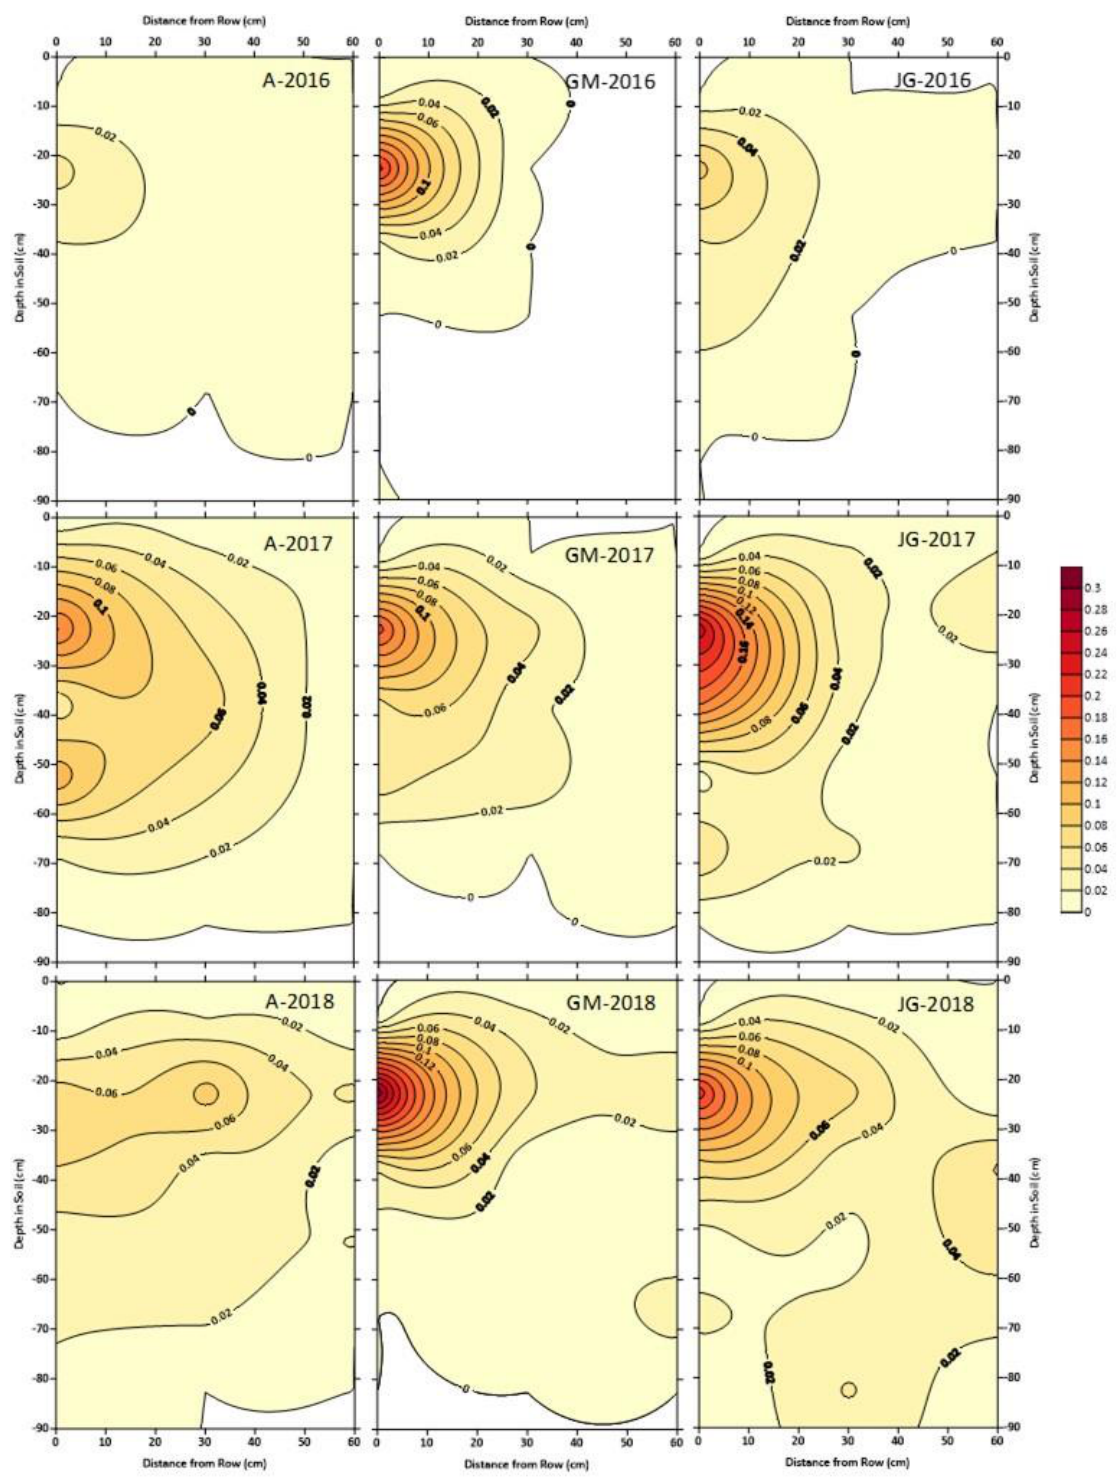
Figure 1. Fleshy root length density (FL-RLD) of three asparagus ( Asparagus officinalis L.) cultivars (Atlas (A), Guelph Millennium (GM), Jersey Giant (JG)) for sampling years 2016, 2017, and 2018. The three cultivars (A, GM, JG) are aligned in the columns while the years (2016–2018) are aligned in the rows. Isolines represent the change in RLD (cm of root length per cm 3 of soil volume) over depth (0–90 cm) and distance (0–60 cm) from the